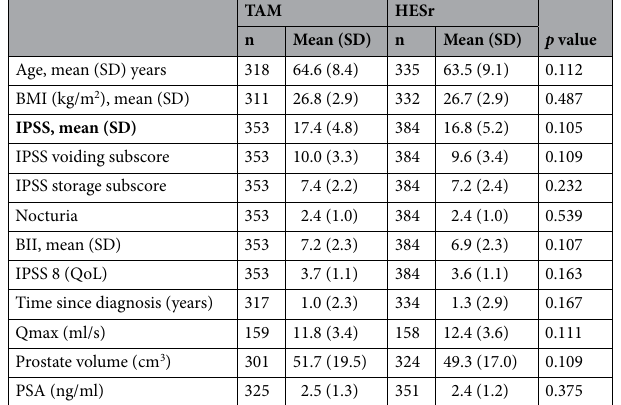
Table 1. Patient baseline characteristics by treatment group (iterative matching sample). TAM: tamsulosin; HESr : hexanic extract of Serenoa repens. BMI: body mass index; IPSS: International Prostate Symptom